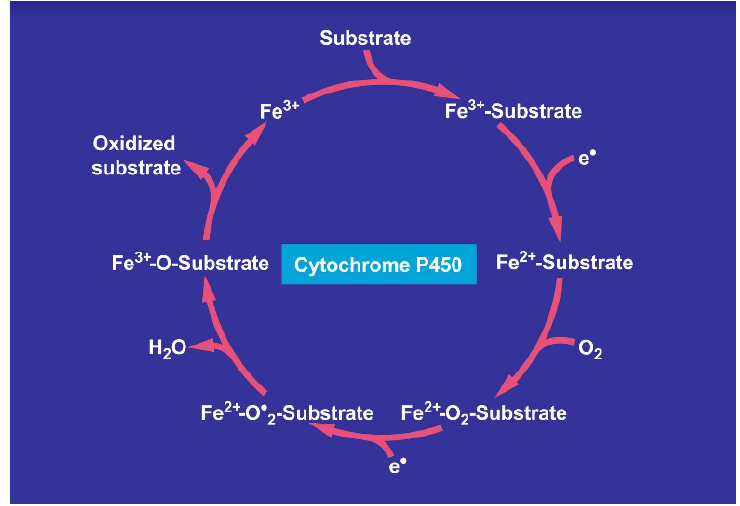
Figure 21. Cycle involving cytochrome P450 for the metabolism of various substrates including carbon tetrachloride. carbon